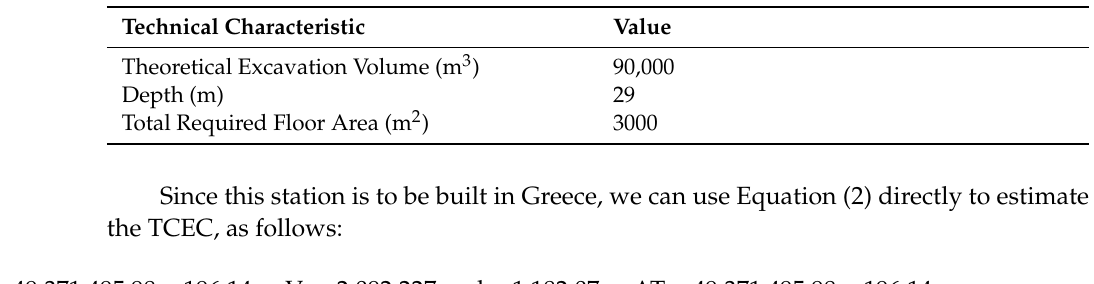
Table 10. Initial predesign technical characteristics of proposed